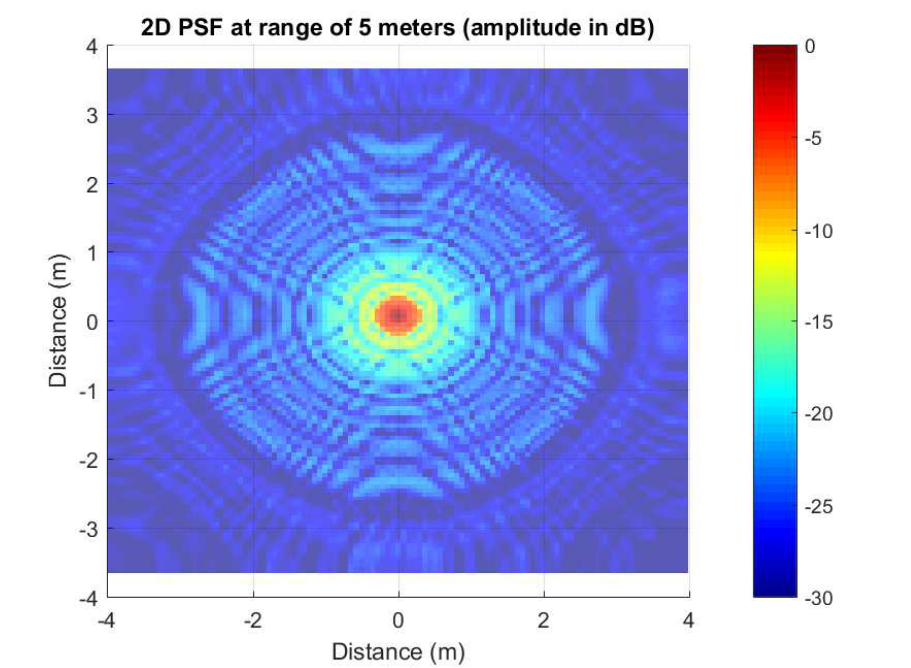
Figure 5. 2D point spread function (PSF) for the point scatterer located at the center ( 0,0 ) at a range of 5 m (amplitude in